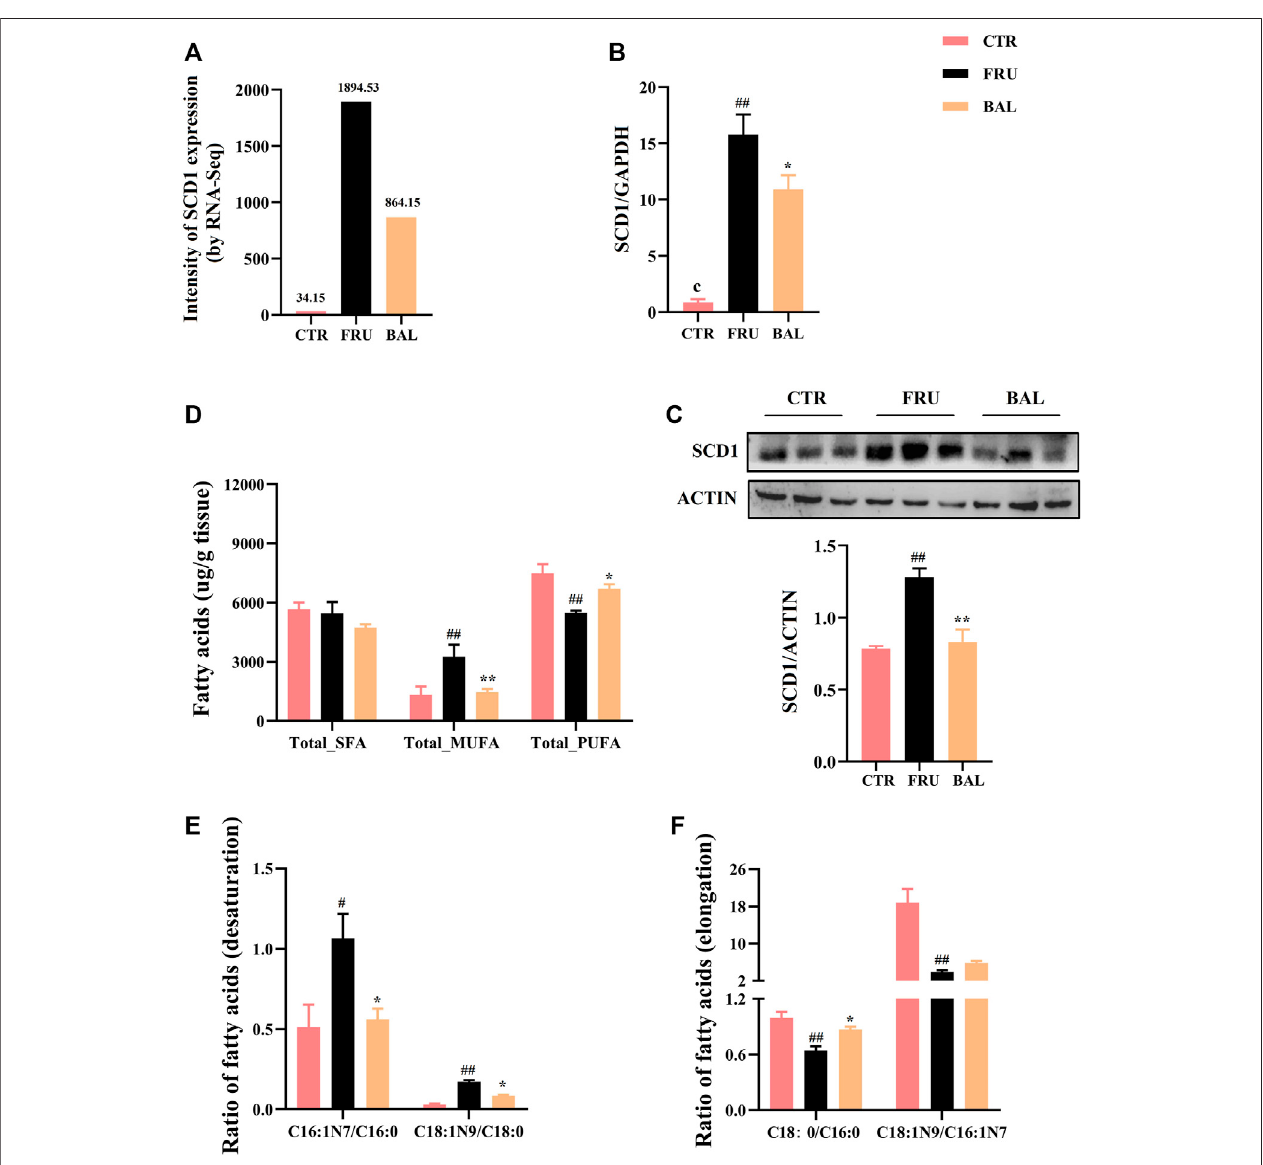
FIGURE 4 | Effects on hepatic fatty acid composition and SCD1 expression caused by BAL treatment in fructose-fed rats. (A) SCD1 expression by RNA- sequencing analysis. (B) SCD1 mRNA level. (C) SCD1 expression in protein level. (D) Total of SFA, MUFA and PUFA in rat liver. (E) SCD1 activity. (F) ELOVL6 activity. Data were represented as Mean ± SEM ( n = 6/group), ## p < 0.01 , # p < 0.05 , compared with CTR; **p < 0.01 , *p < 0.05 , compared to FRU.